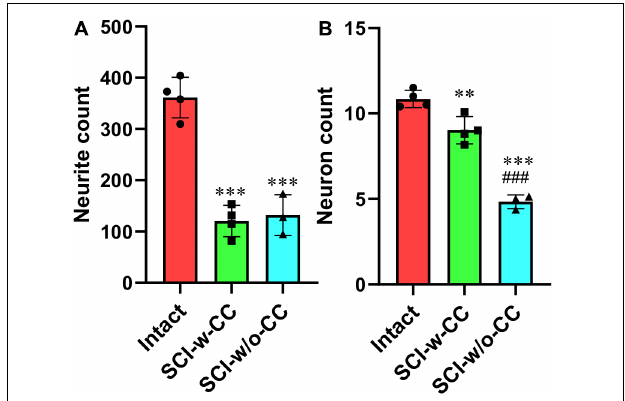
FIGURE 7 | Statistic data relating to the reduction in beta-III-tubulin-positive CS-neurites and motor neurons. Beta-III-tubulin positive neurites (A) and motor neurons (B) were quantified using Image J software. Statistical analysis was then performed to compare the intact, SCI-w-CC and SCI-w/o-CC groups. Data represent mean ± SD. Statistical analysis involved one way ANOVA and was carried out with SPSS 17.0 software. ∗∗ P < 0.01, ∗∗∗ P < 0.001, as compared with the intact group. ### P < 0.001, as compared with the SCI-w-CC